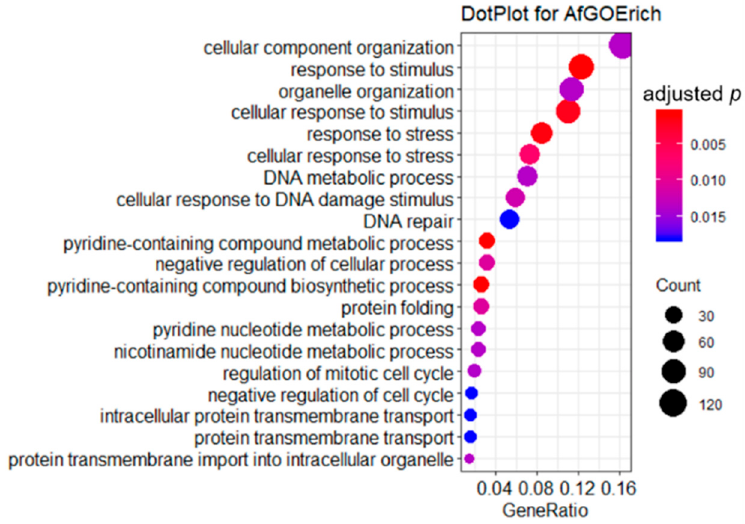
Figure 4. Enriched GO terms of DEGs. This figure shows the top 20 terms of GO enrichment analysis of common DEGs in PAE treatment and control groups.